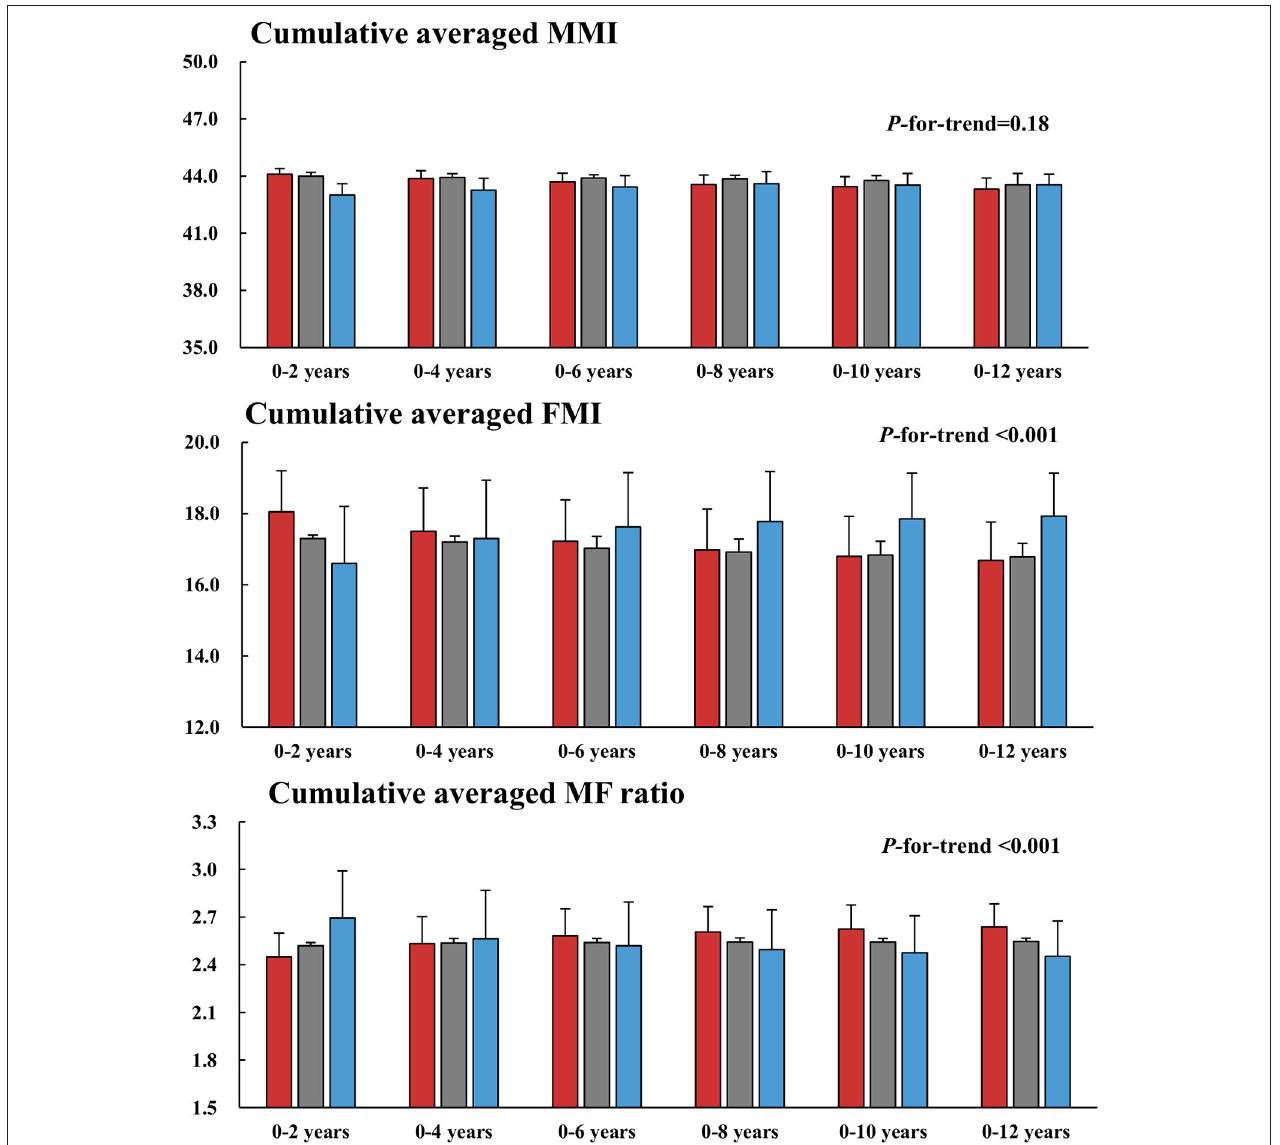
FIGURE 5 | Longitudinal changes in the MMI, FMI, and MF ratio across the trajectories. Cumulative averaged values of the MMI, FMI, and MF ratio were calculated as the mean of measurements of each parameter during the follow-up period. MMI, muscle mass index; FMI, fat mass index; MF, muscle to